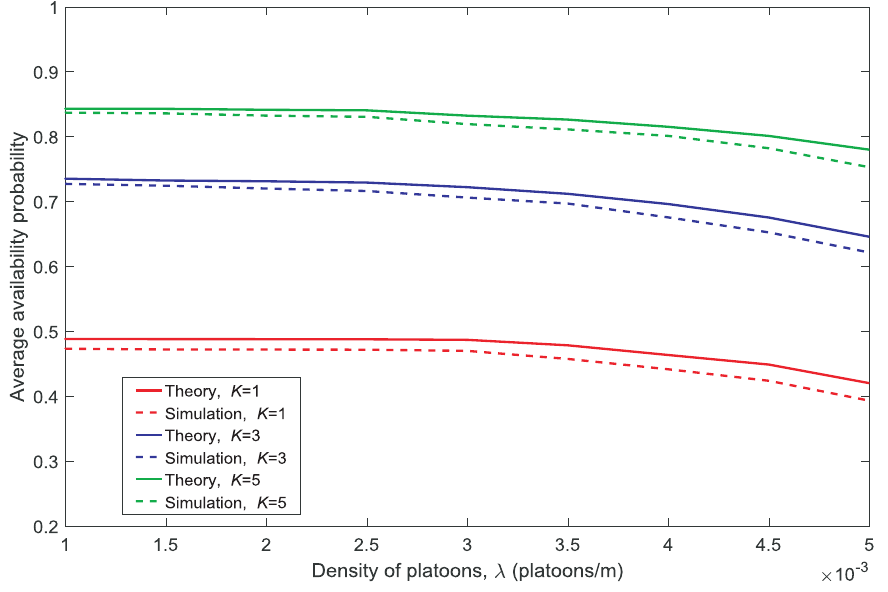
Figure 2. Average availability probability for different densities of platoons λ ( d V = 10, V = 10, N = 5 )